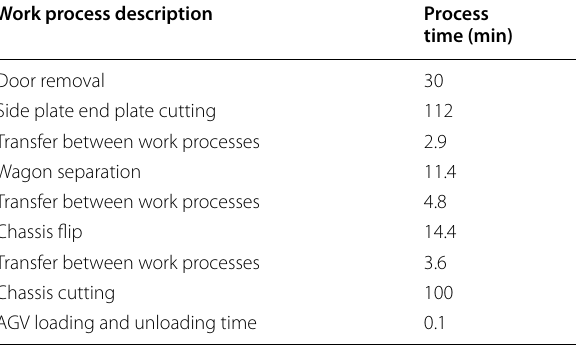
Table 2 Simulation parameter input